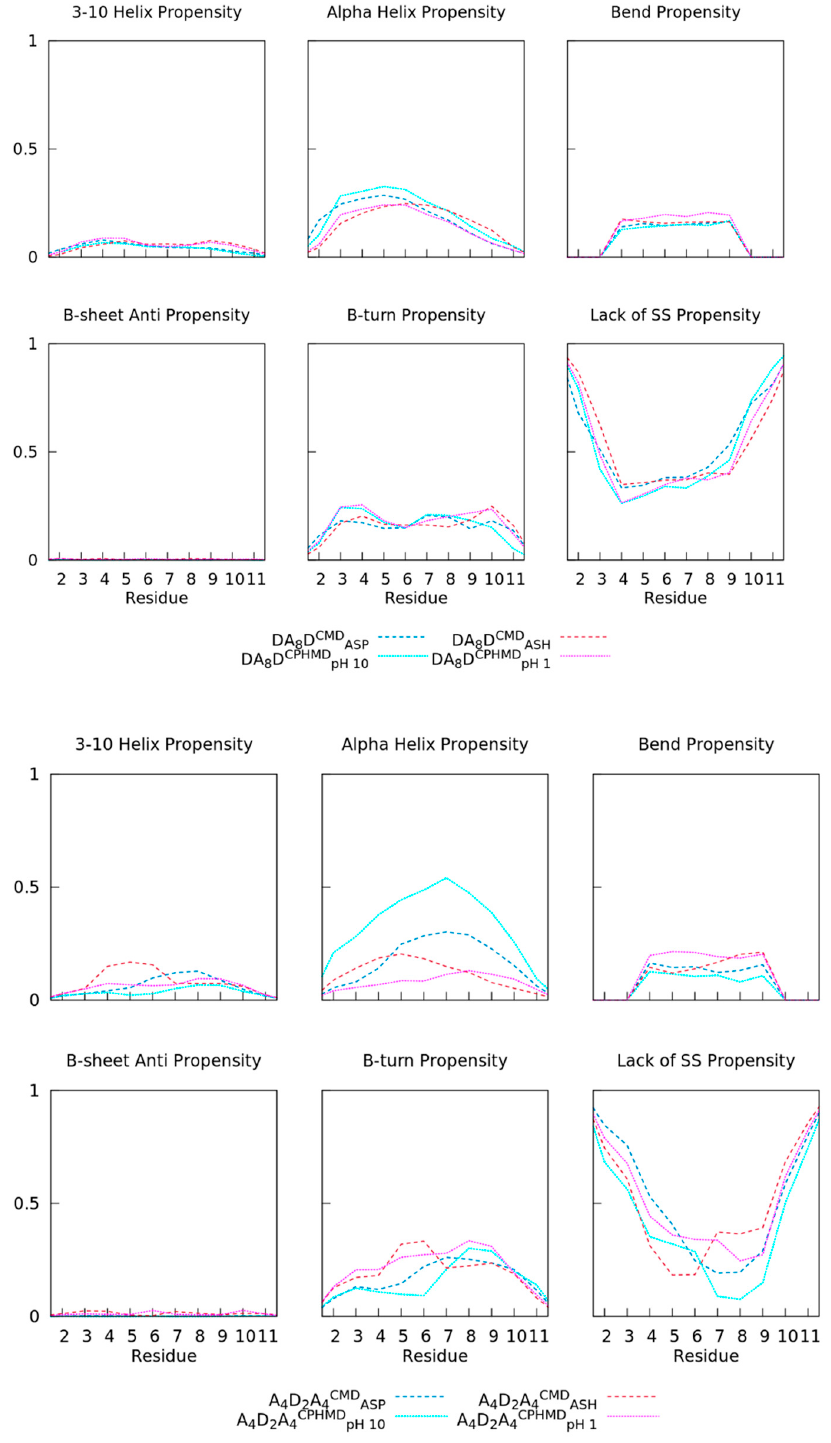
Figure 8. Propensity factors of the secondary structure (fSS) of each amino acid in the DA 8 D ( top ) and A 4 D 2 A 4 ( bottom ) oligopeptides using the DSSP algorithm. Para Β -sheet and π -helices were omitted due to their absence. Dashed and dotted lines correspond to fixed (cMD) or dynamic (cpHMD) protonation sampling during the simulation.